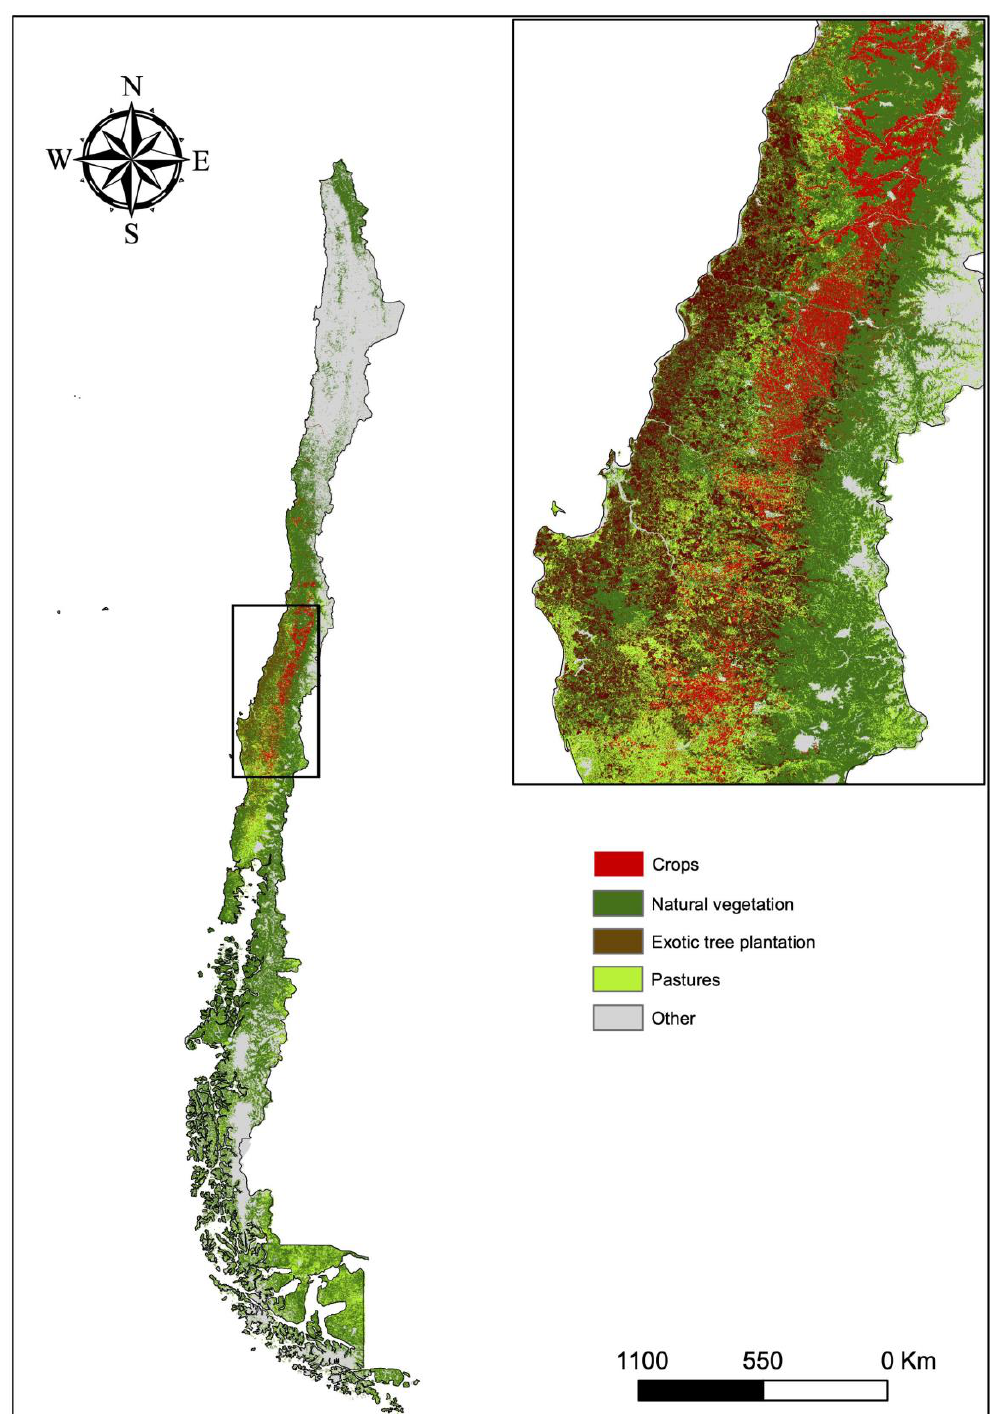
Figure 4. General land cover map for Chile [53]. Land Use/Land Cover was classified into crops, natural vegetation (forests or shrubland), exotic tree plantations, pastures (natural or managed), and other (wetlands, water, impervious surface, bare soil, snow, ice). The inset highlights the crop area (in red) in central